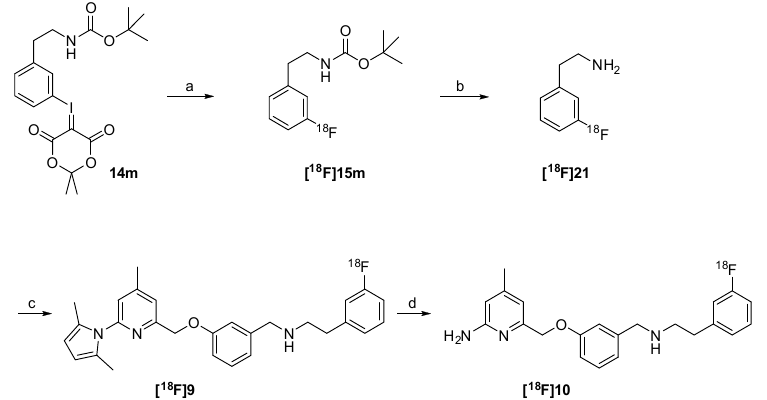
Figure 3. Influence of reaction temperature and time of the nucleophilic radiofluorination of ylide 14m , yielding [ 18 F]15m . For reagents and conditions see Scheme 4, step a.